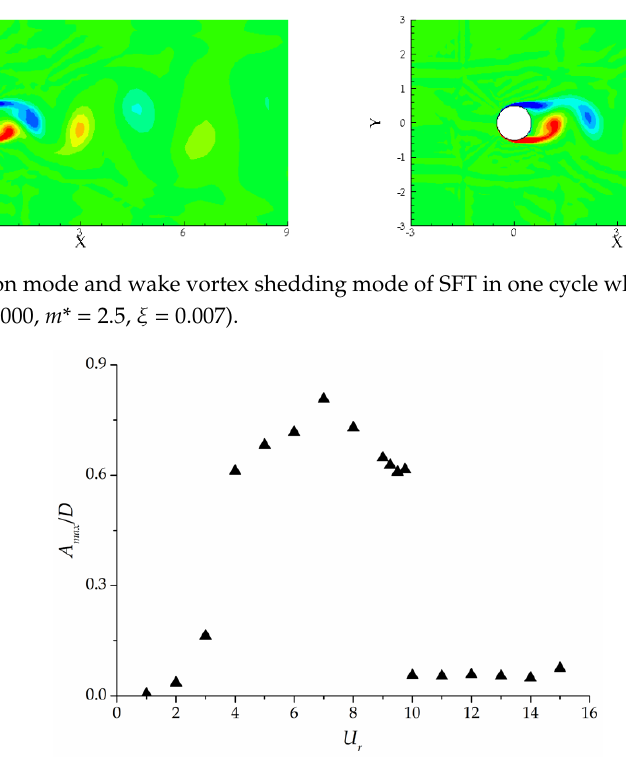
Figure 10. Vibration amplitude of SFT versus reduced velocity under Re = 50,000, m * = 2.5 and ξ =